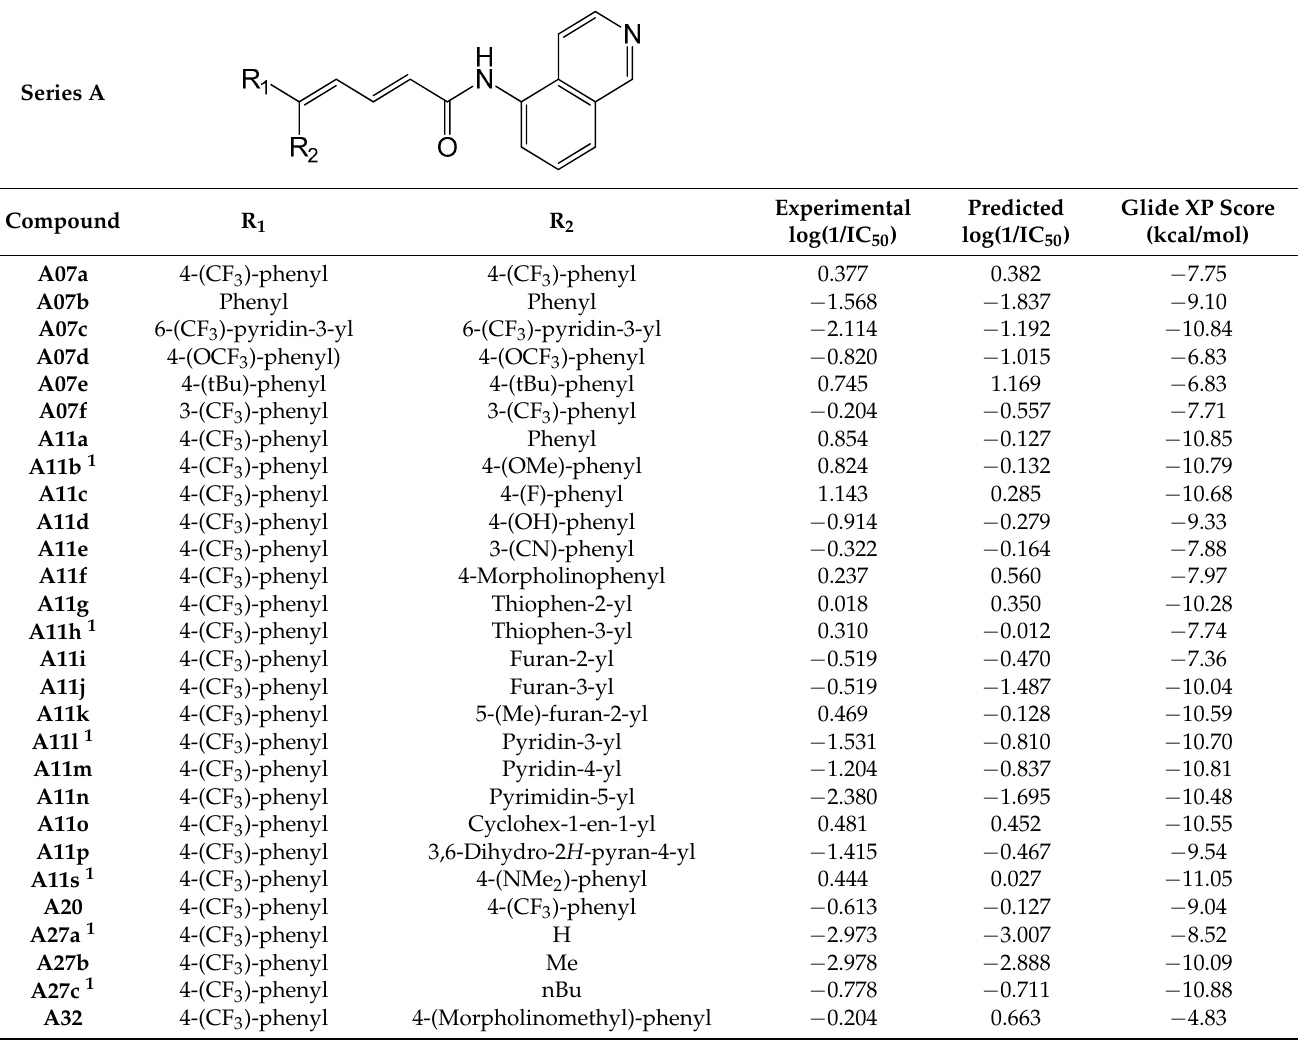
Table 1. Structures of 5,5-diarylpentadienamides (DPDAs) as transient receptor potential vanilloid 1 (TRPV1) antagonists. Experimental and predicted log(1/IC 50 ) values (in nM) using a 2D autocorrelation quantitative structure–activity relationship (QSAR) model and Glide XP (extra precision) scoring energy values.